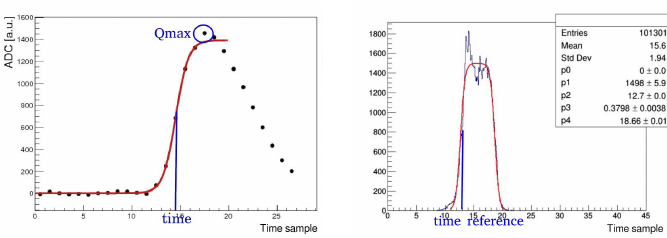
Figure 2: On the left, the signal collected by an APV-25 channel as a function of the 27 time samples and the fitting function used to extract the arrival time on this channel. On the right, the time distribution of the collected signal in a run and a double Fermi-Dirac function fit used to extract the time reference needed by the µ TPC